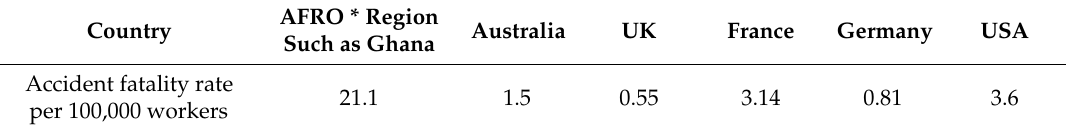
Table 1. Occupational accident fatality rate for di ff erent countries. AFRO * Region Country Such as